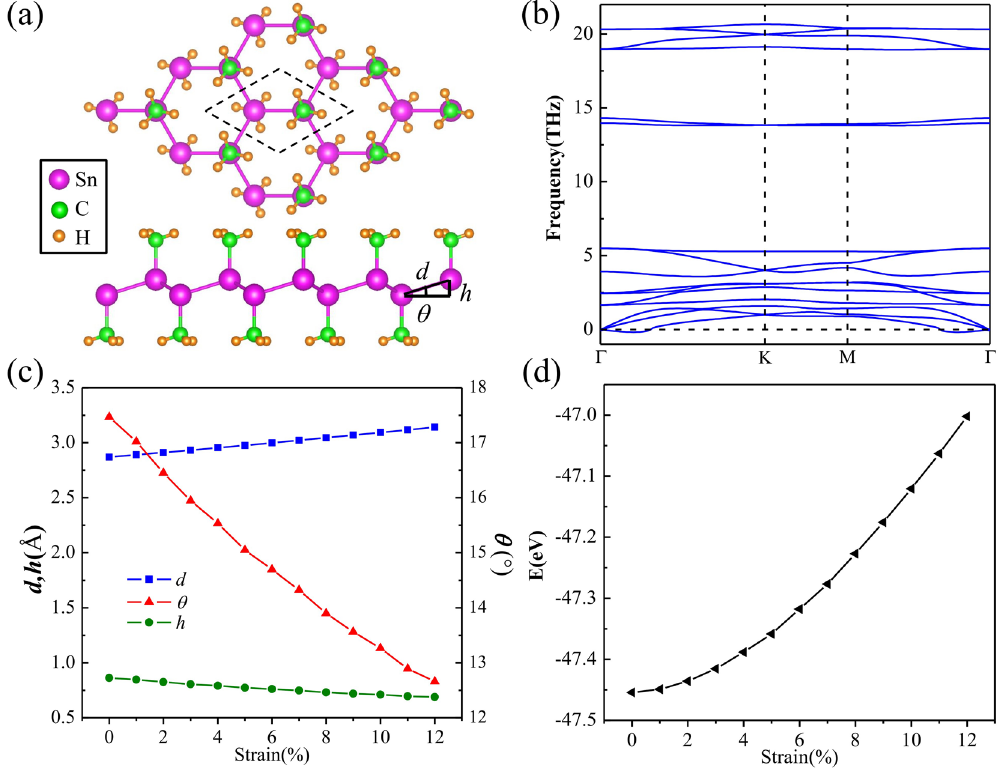
Figure 1. ( a ) Top and side views of atomic structure of SnCH 3 film. ( b ) Corresponding phonon spectrum of SnCH 3 film in (a). ( c ) The evolutions of the buckling height ( h ), Sn-Sn bond length ( d ) and buckling angle ( θ ) indicated in ( a ) under tensile strain. ( d ) The variation of total energy as a function of tensile